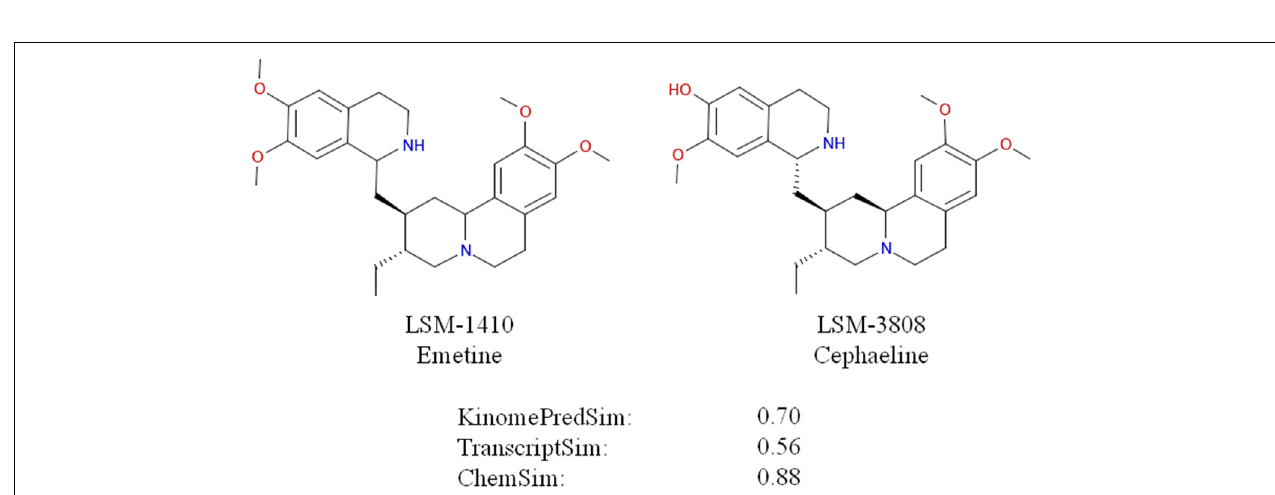
FIGURE 11 | Similar compounds (ChemSim of 0.88) with high KinomePredSim and TranscriptSim (based on L1000 in A549